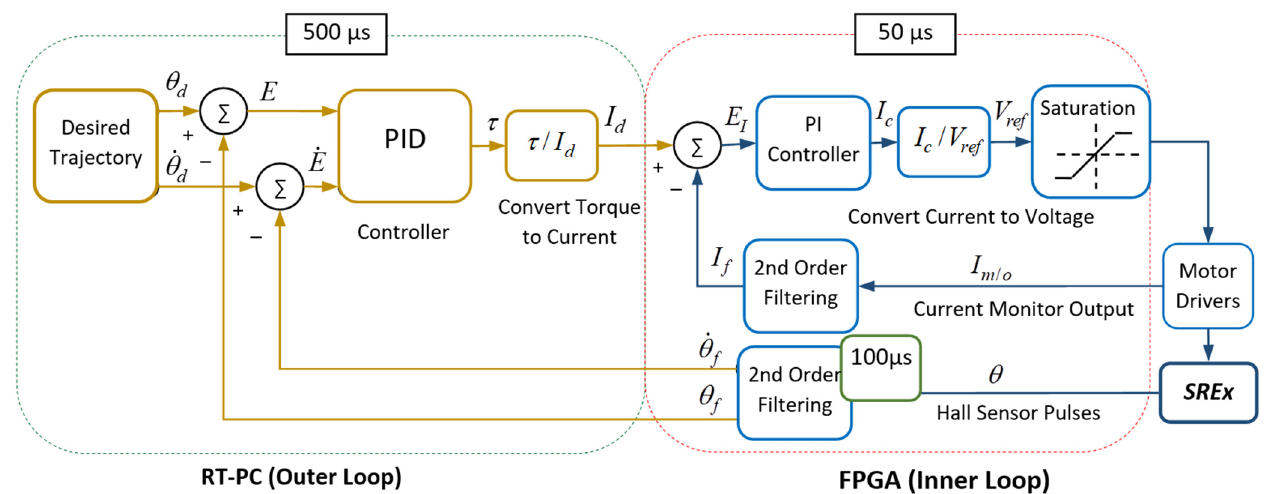
Figure 5. Control